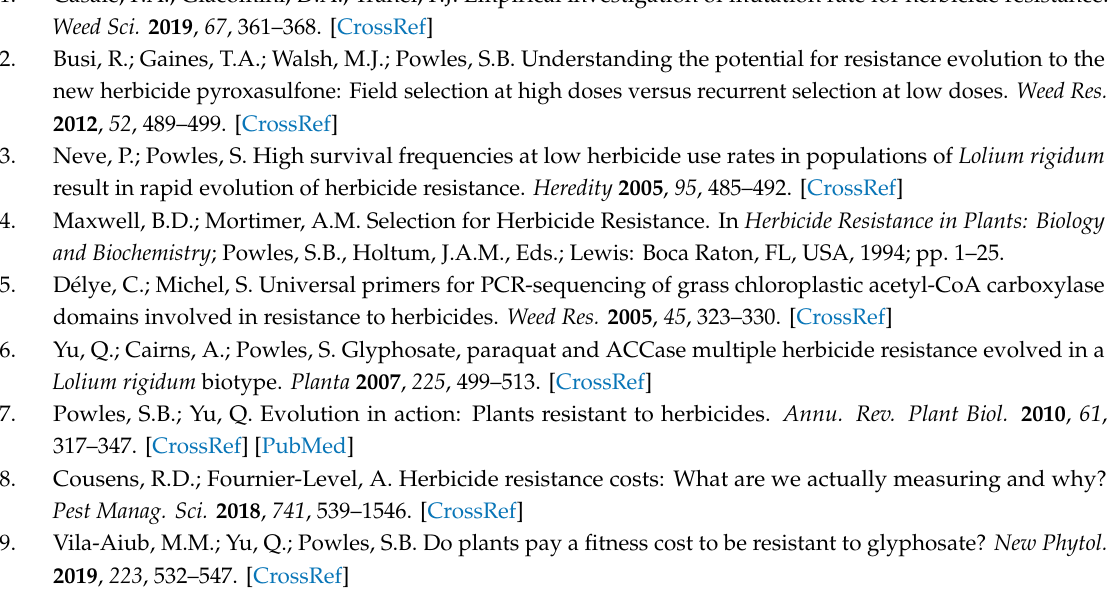
Supplemental Table S1. Overview of the sequencing reads obtained from each sample.; Supplemental Table S2. Functional annotations of unigenes in the databases.; Supplemental Table S3. DEGs with opposite expression LS and LR.; Supplemental Table S4. Go function enrichment of up- or downregulated DEGs in LS comparison.; Supplemental Table S5. Go function enrichment of up- or downregulated DEGs in LR comparison.; Supplemental Table S6. The number of DEGs in di ff erent comparison settings.; Supplemental Table S7. The sequences of RT-PCR